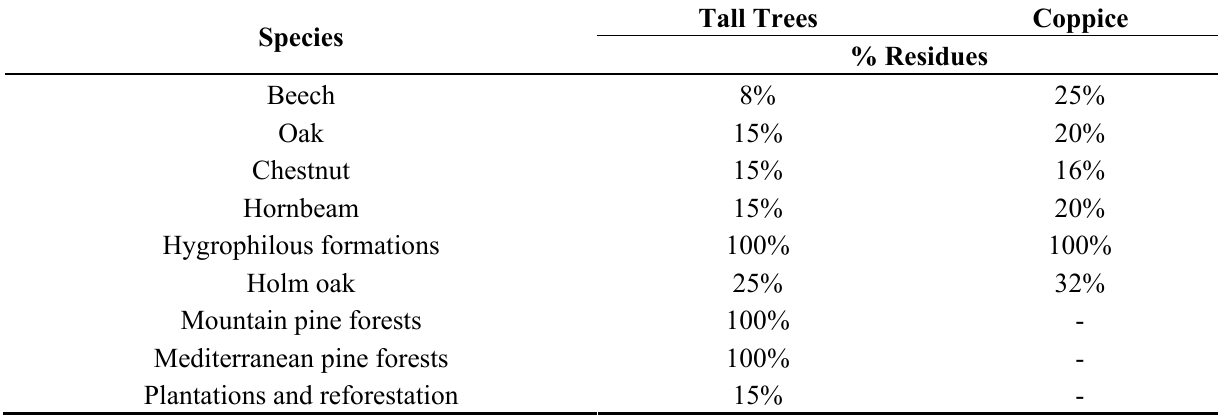
Table 3. Percentage of waste by type of wood. Source: elaboration of the RU on [37,38].